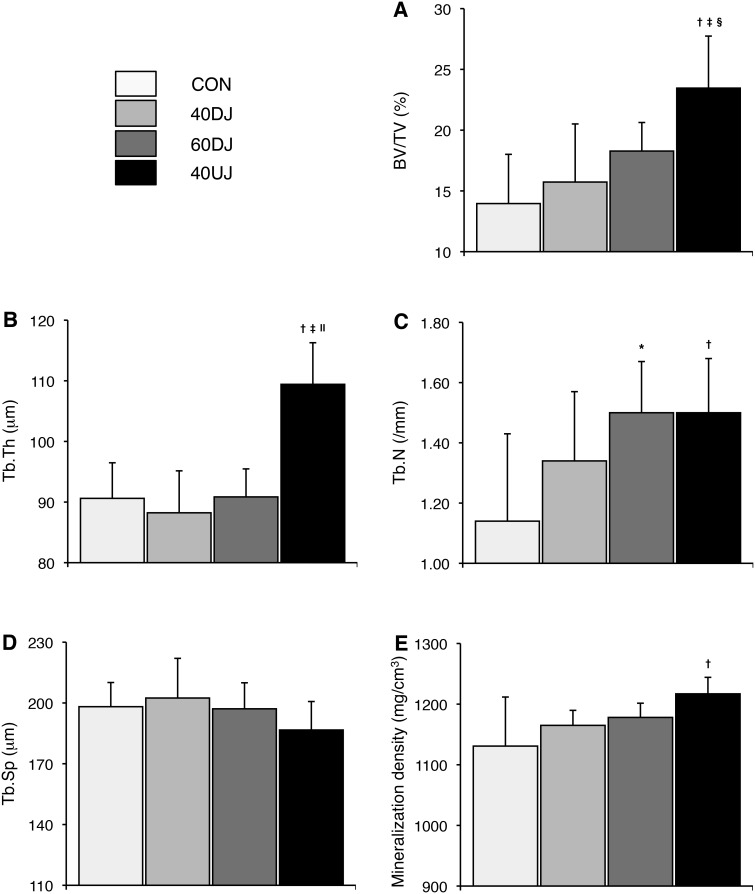
Microstructural parameters in the femoral metaphysis of rats that jumped downwards from a height of 40 (40DJ) or 60 (60DJ) cm, or upwards to a height of 40 cm (40UJ) or remained sedentary (CON) measured by micro-CT.A, Trabecular bone volume fraction (BV/TV); B, trabecular thickness (Tb.Th); C, trabecular number (Tb.N); D, trabecular separation (Tb.Sp); E, degree of trabecular bone mineralization. Significant differences: *p<0.01 and †
p<0.001 vs. CON; ‡
p<0.001 vs. 40DJ; §
p<0.05 and ll
p<0.001 vs. 60DJ.